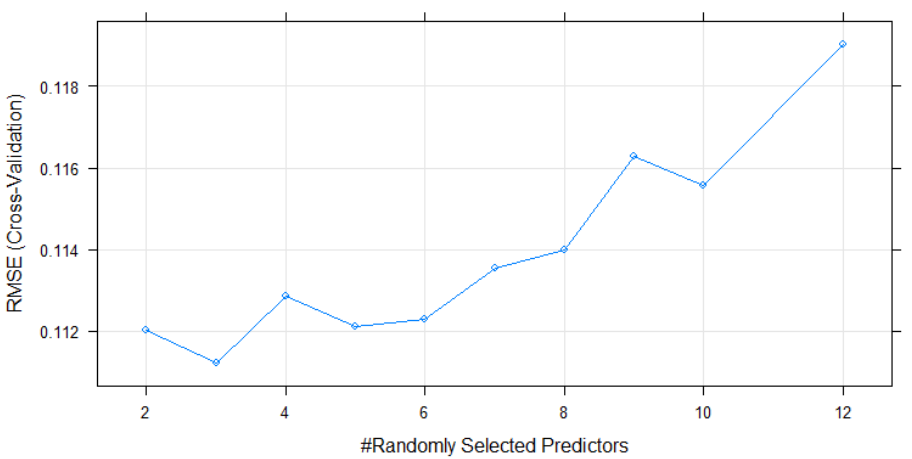
Figure 5. Random forest (RF) model performance (in log-transformed training data) with different mtry values.